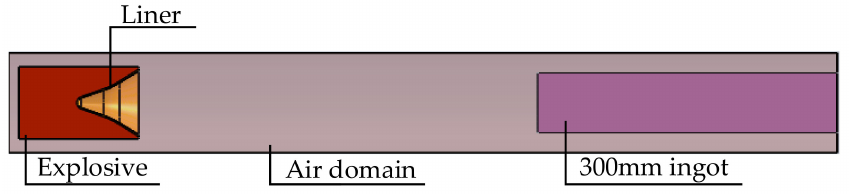
Figure 3. Structural model of penetration into a steel